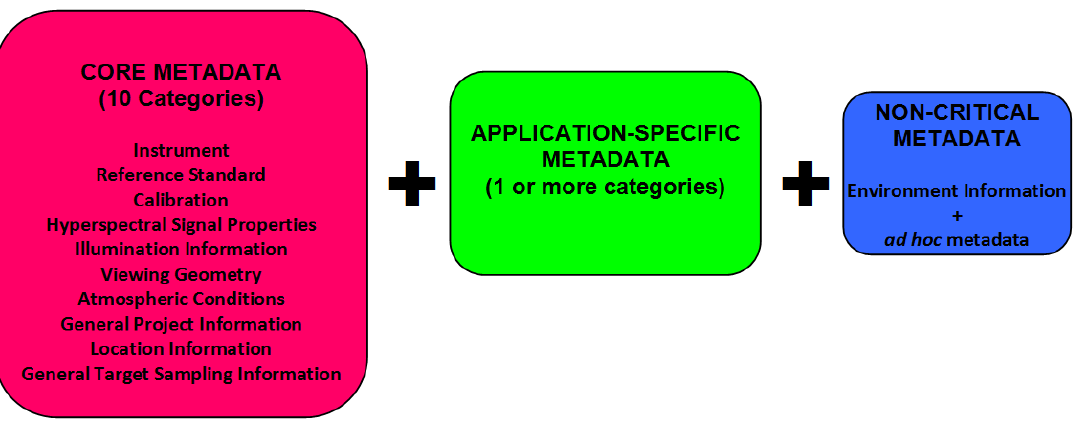
Figure 8. A metadataset for a given field spectroscopy campaign, including the core set common to all campaigns, application-specific metadata, and non-critical metadata.